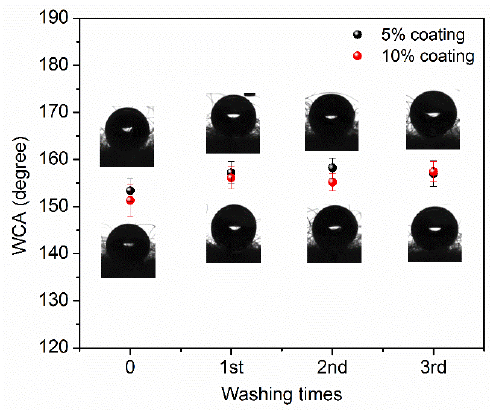
Figure 6. Water contact angle of 5% and 10% TiO 2 -coated cashmere before and after washing.